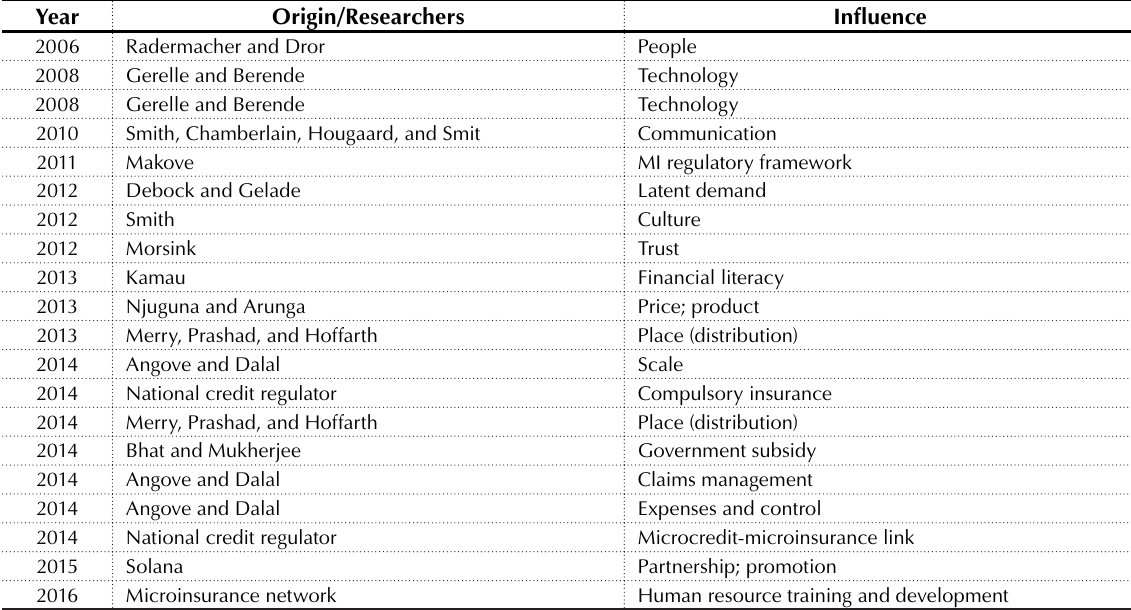
Table 1 lists the various business success influenc- es considered.